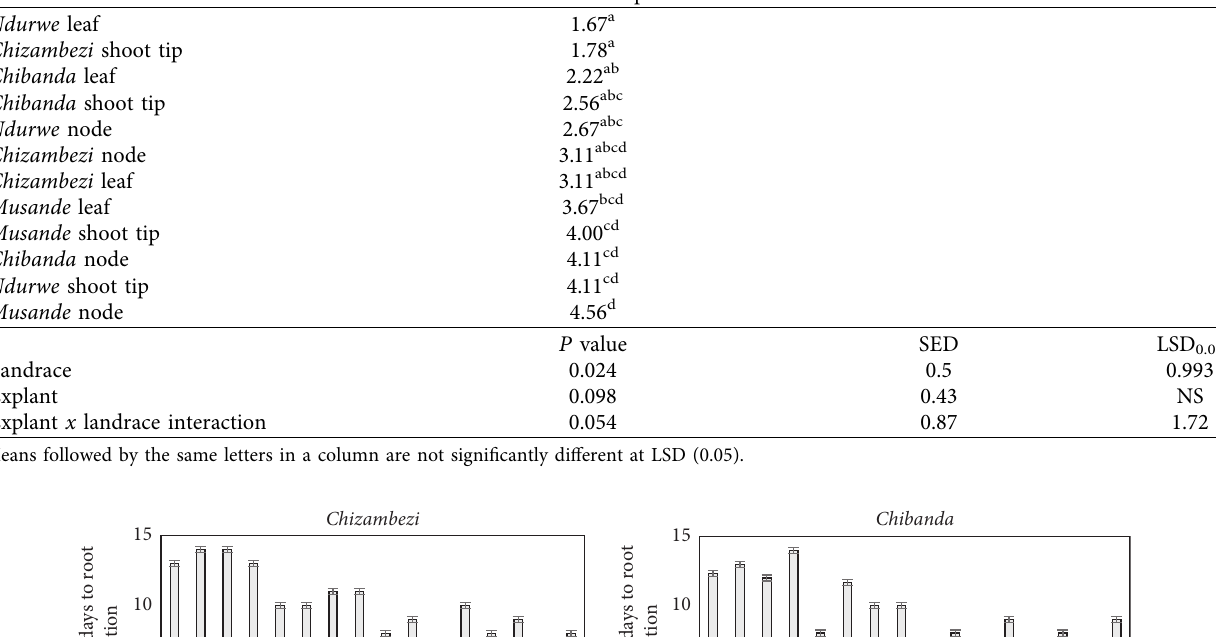
Table 3: Effect of landrace and explant on the average number of nodes per shoot. Treatment